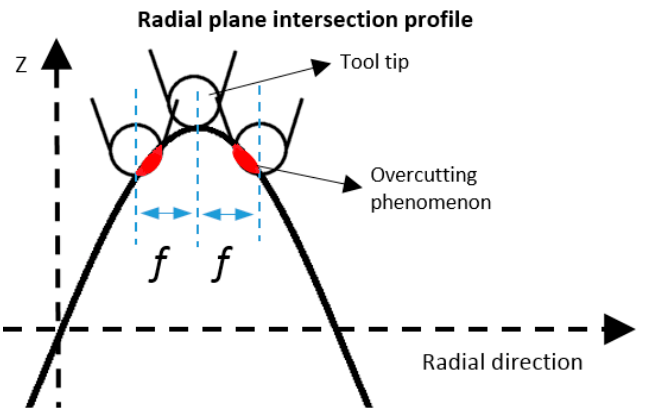
Figure 6. Schematic of overcutting phenomenon caused by circular tool tip.